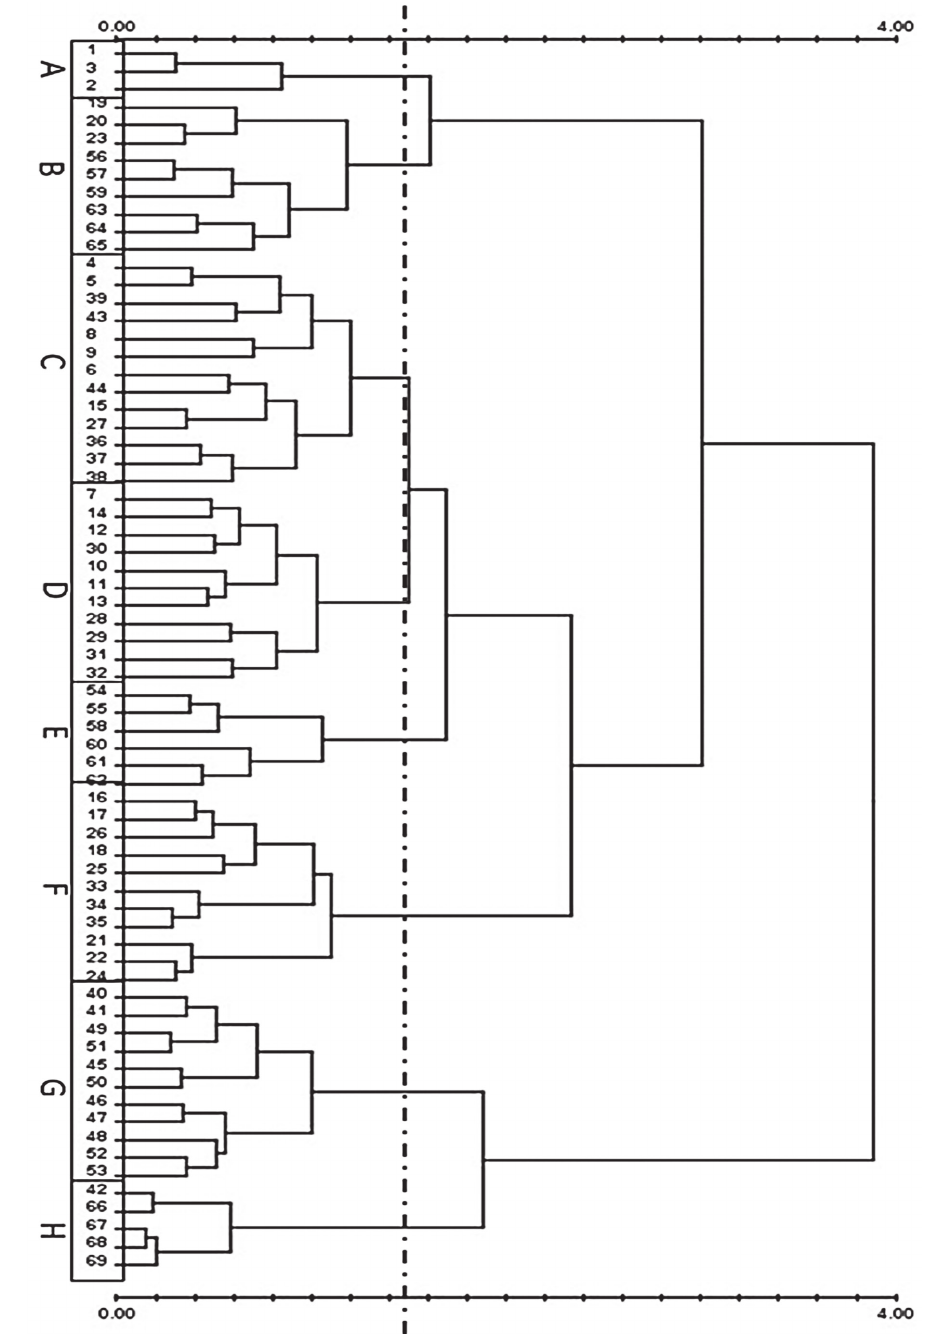
Figure 2 - Data matrix dendrogram with the different